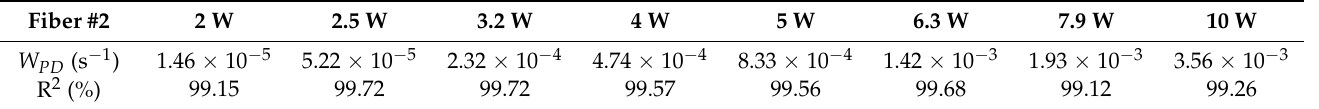
Table 2. Calculated PD rates of different pump powers of Fiber #2.